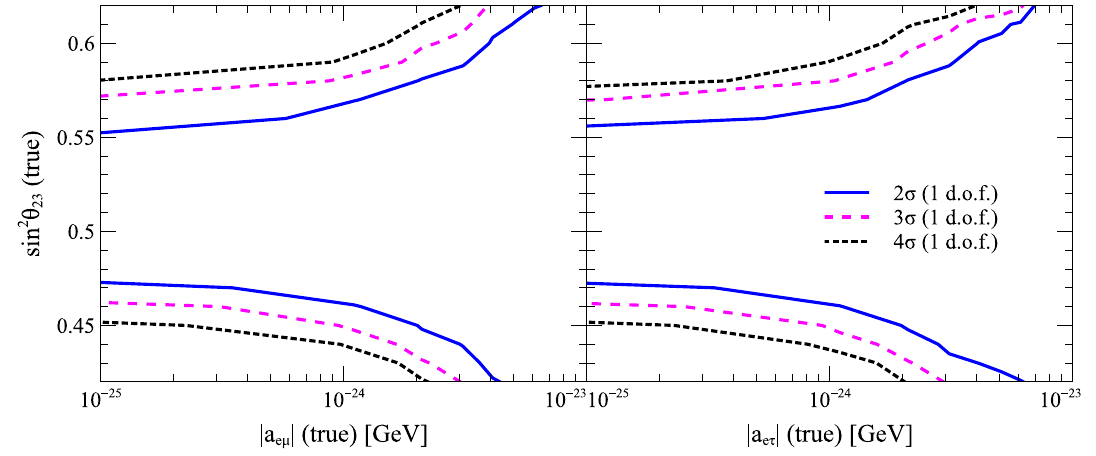
Fig. 7 Deterioration of the θ 23 octant discovery potential as a function ofthestrengthofthetrueLIVparameter | a e μ | ( | a e τ | )inleft(right)panel assuming NO both in data and theory. In both the panels, we marginal- ize over the test values of θ 23 in the wrong octant and the standard CP phase δ (both true and test) in its full range of [− π,π ] . We marginalize